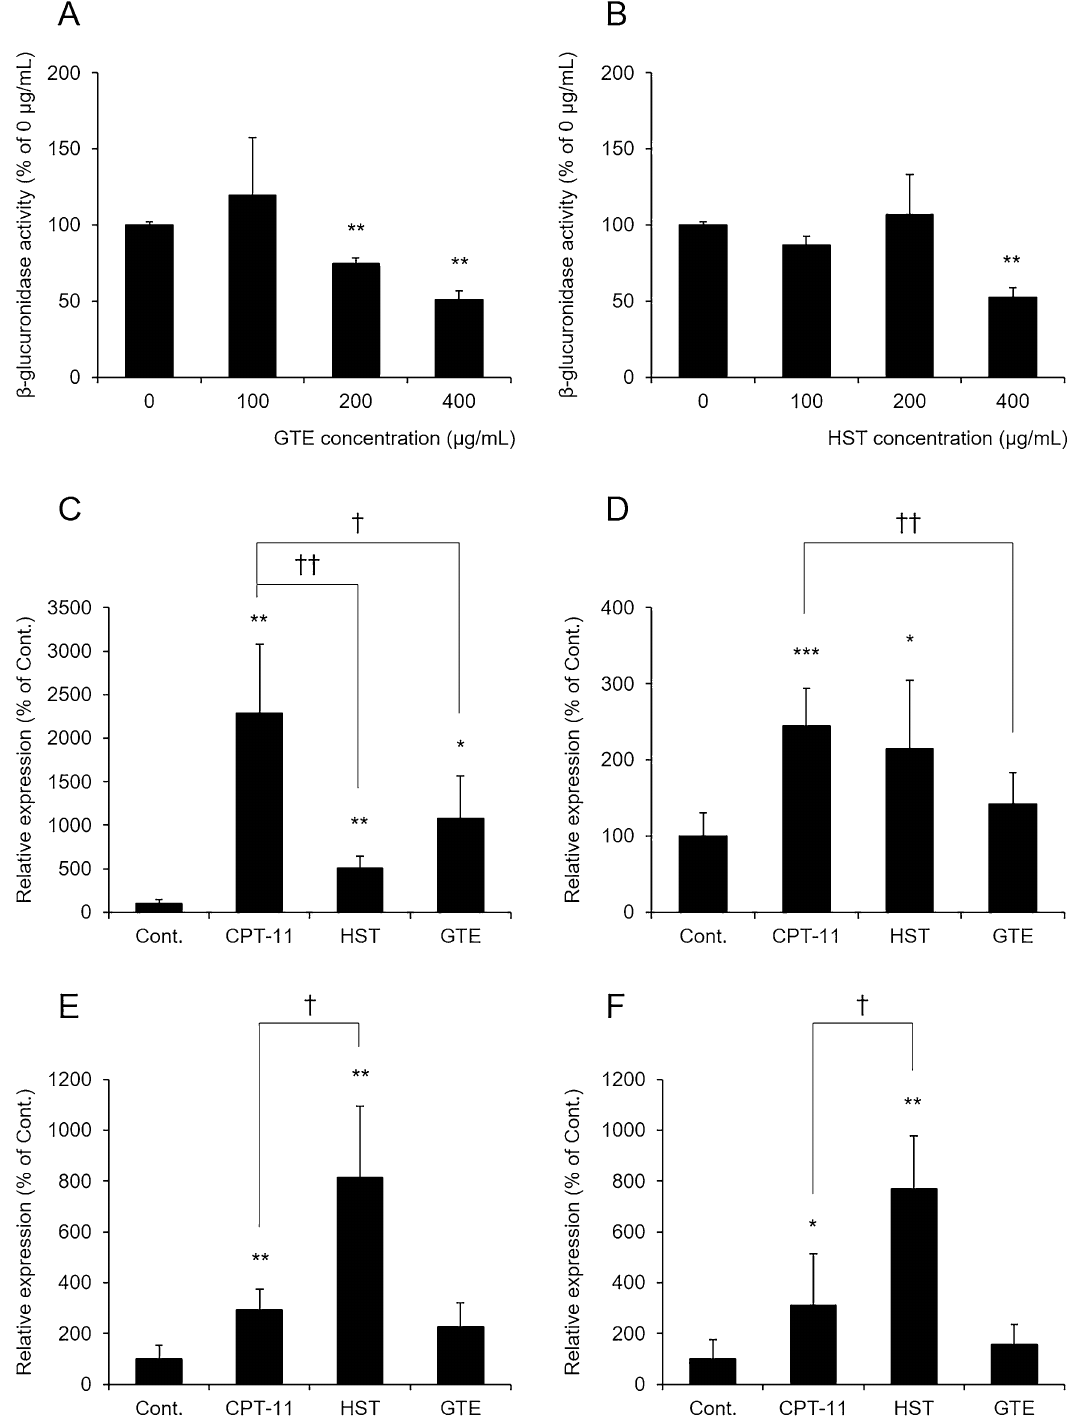
Figure 2. Effects of GTE on β-glucuronidase activity and bacteria involved in β-glucuronidase production. ( A,B ) GTE ( A ) or HST ( B ) was mixed with enzyme solution extracted from rat feces, and β-glucuronidase activity was evaluated. The mean value in the control group (0 μg/mL) is shown as 100% (mean ± S.D., n = 3, ** p < 0.01 vs. 0 μg/mL). ( C–F ) Rats were administered CPT-11 or lactic acid buffer intravenously for 4 days, and HST or GTE was administered in combination. The levels of B. fragilis ( C ), E. coli ( D ), C. perfringens ( E ), and E. eligens ( F ) were measured by real-time PCR. Each value was normalized using 16S rRNA levels and is shown as 100% of the mean value in the control group (mean ± S.D., n = 5, * p < 0.05, ** p < 0.01, *** p < 0.001 vs. Cont., † p < 0.05, †† p < 0.01 vs.